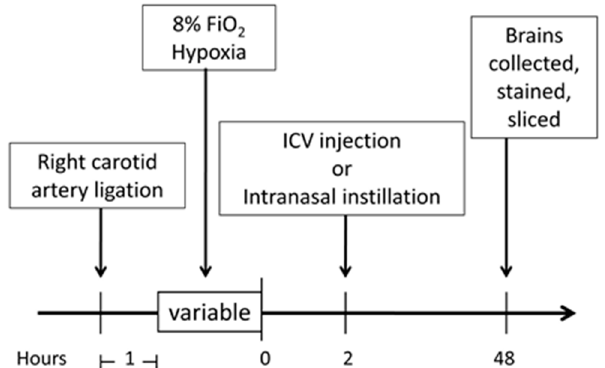
Figure 1. Experimental protocol timeline. Outline of the experimental timeline is described in the materials and methods section. The hypoxia time was varied slightly depending on the experimental groups (dexamethasone, hydrocortisone, and lipopolysaccharide (LPS) models) and are detailed in each respective methods section. ICV, intracerebroventricular.